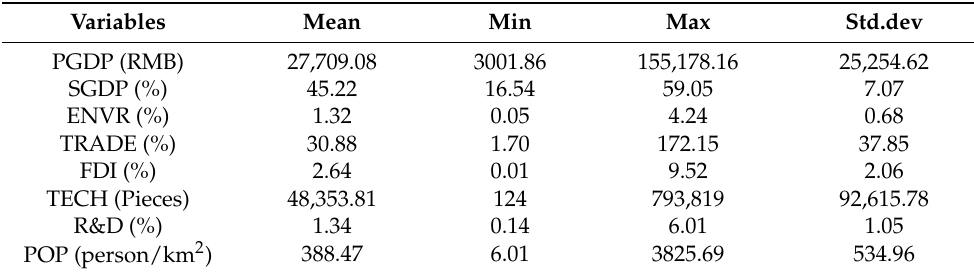
Table 5. Descriptive statistics of the variables.